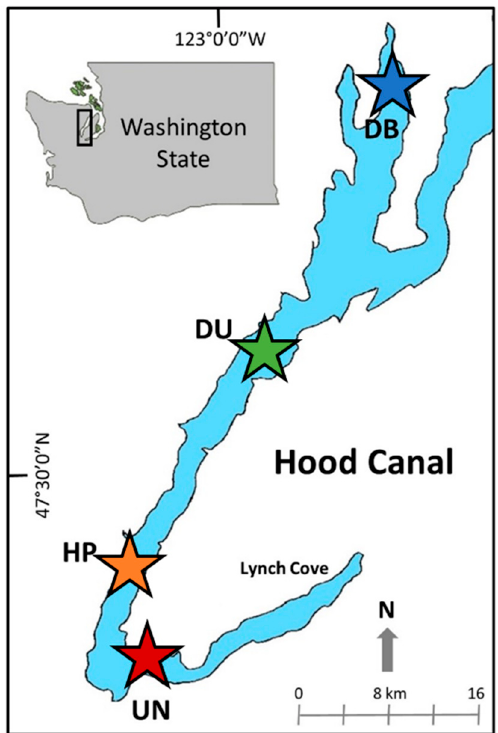
Figure 1. Map of Hood Canal in Puget Sound, Washington, USA. Stations sampled in 2012 and 2013 represent a range in dissolved oxygen conditions from north to south: Dabob (DB), Duckabush (DU), Hoodsport (HP), and Union (UN).